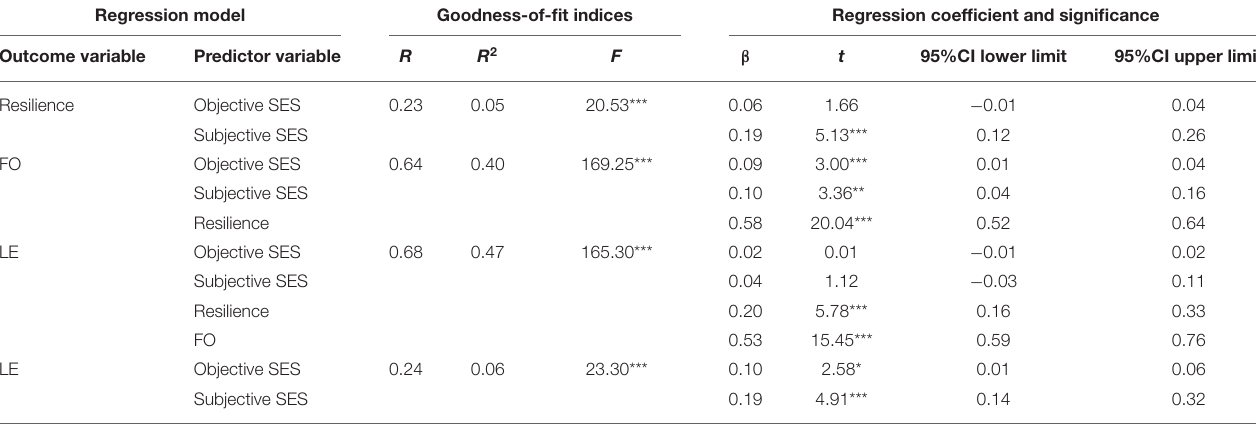
TABLE 2 | Multiple mediation analysis